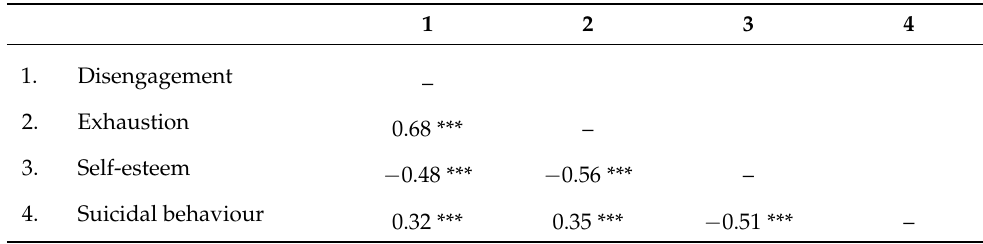
Table 4. Pearson’s correlations.